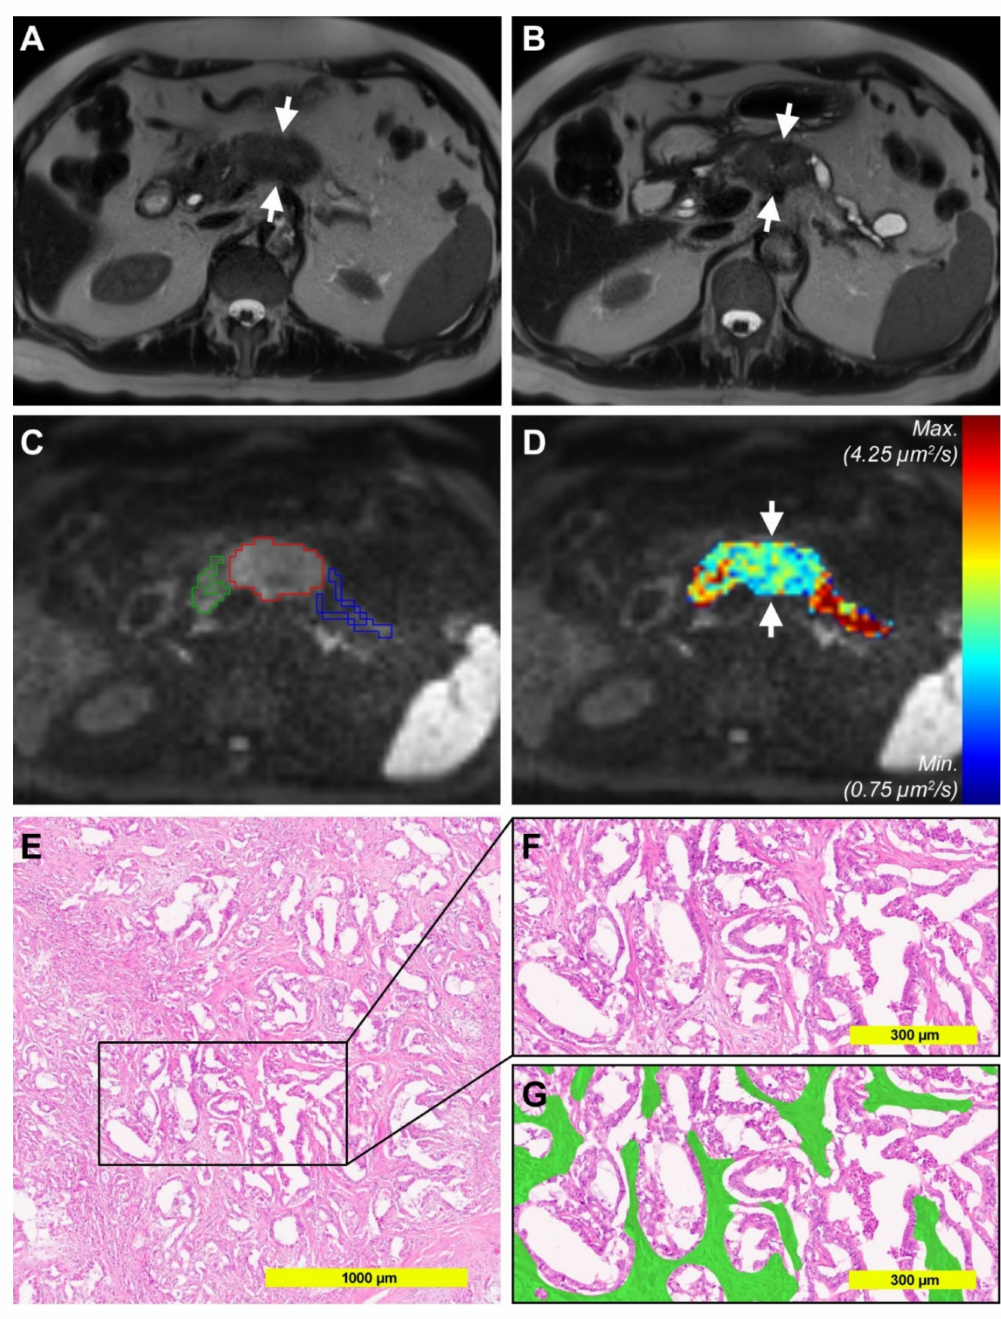
Figure 6. Example pictures of a 75-year-old male patient with low stroma percentage. ( A ) Axial Half-Fourier-Acquired Single-shot Turbo spin Echo (HASTE) T2-weighted image showing the almost isointense tumor in the pancreatic body ( arrows ). ( B ) Axial T2-weighted image at the level of the pancreatic body and tail showing the tumor ( arrows ), upstream dilatation of the main pancreatic duct with concomitant parenchymal atrophy and a cystic lesion in the tail. ( C ) Di ff usion-weighted image (DWI) with b-value 1000 s / mm 2 with volumes of interest surrounding the tumor (VOI tumor , red ), the downstream parenchyma (VOI downstream , green), and the upstream parenchyma (VOI upstream , blue) from reader 1. ( D ) Corresponding color-coded D map. Note that the tumor is colored in green and blue, representing moderate D values. Mean D tumor for both readers was 2.282 µ m 2 / s, mean D upstream was 3.292 µ m 2 / s, and D downstream was 2.593 µ m 2 / s. ( E , F ) Cutouts of a representative HE section from the histopathological specimen. ( G ) Segmented stroma compartment ( green ) shows low stroma percentage (25% for the analyzed